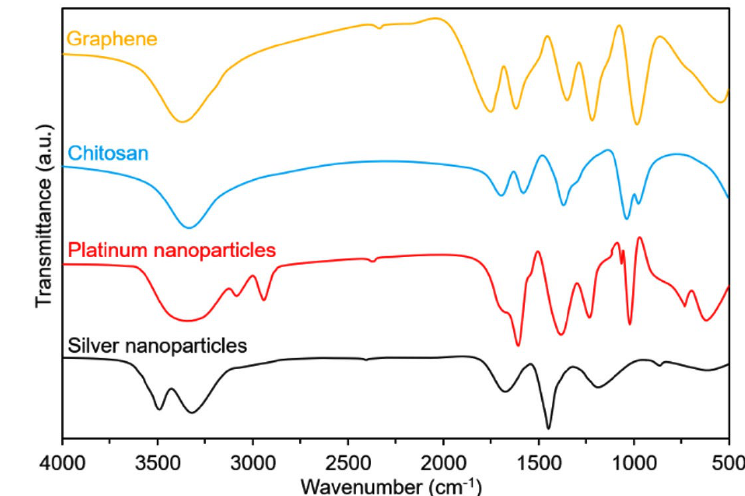
Fig. 5. FTIR profiles of respective polymeric materials and